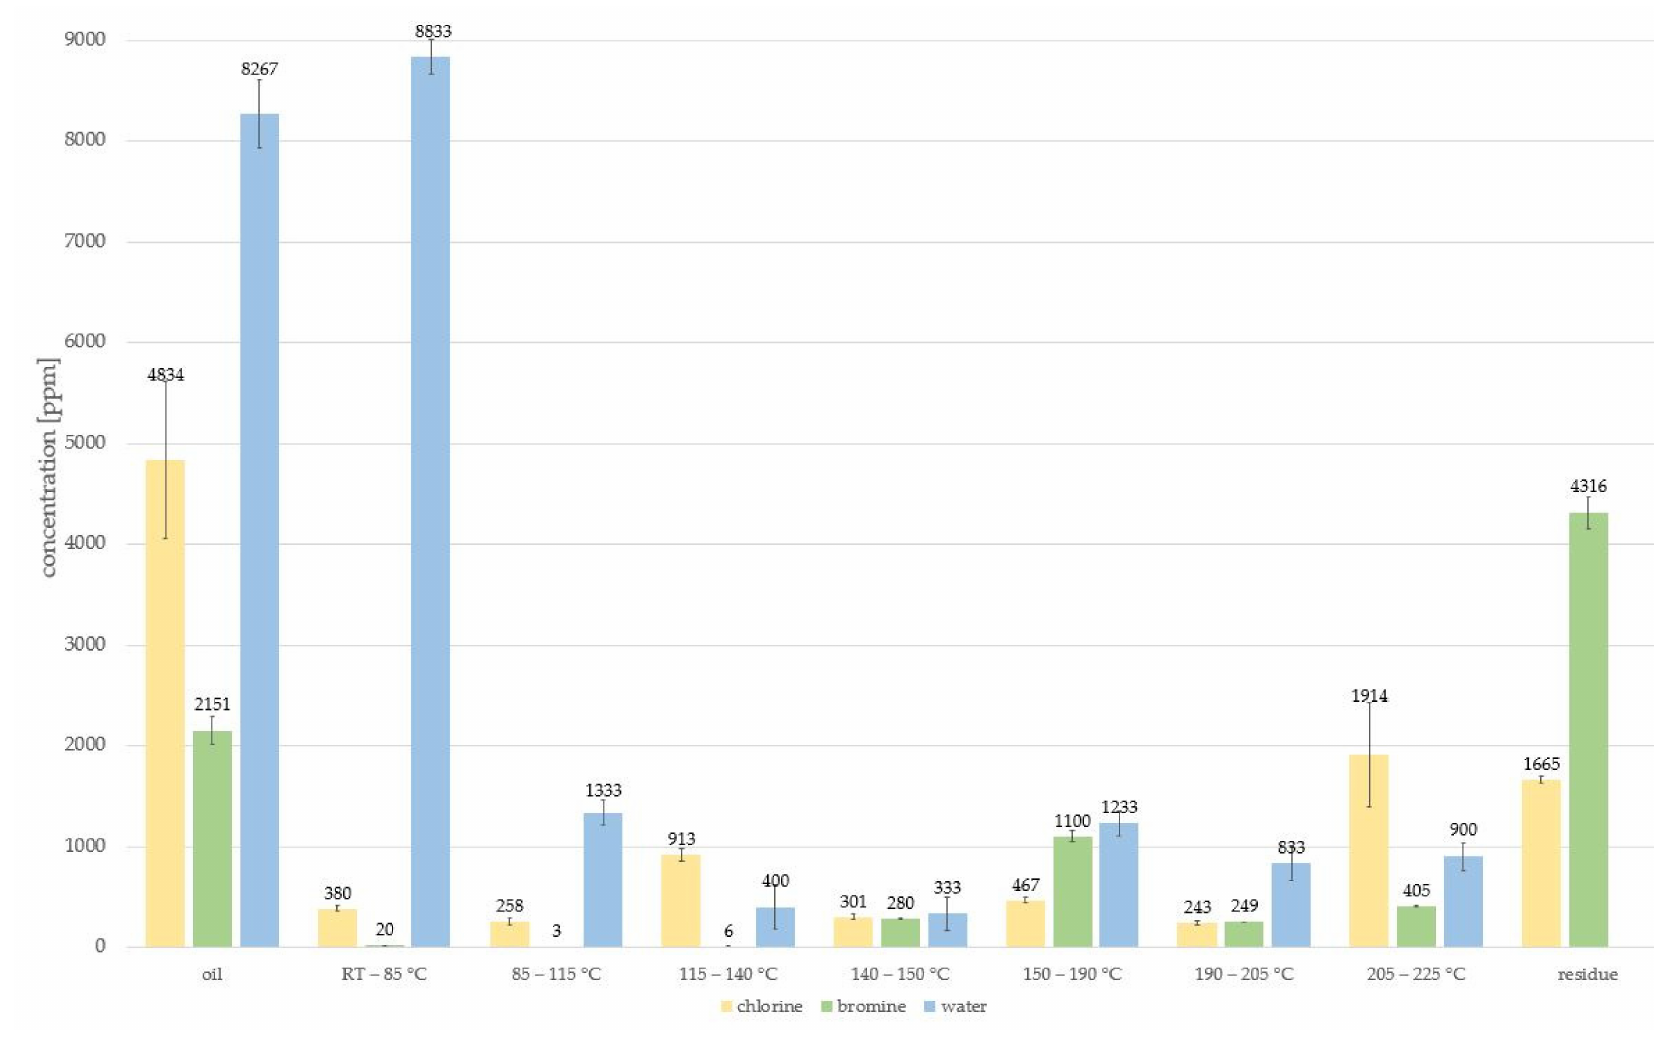
Figure 3. Energy dispersive X-ray fluorescence (EDXRF) results and water concentration analysis of oil and distillate